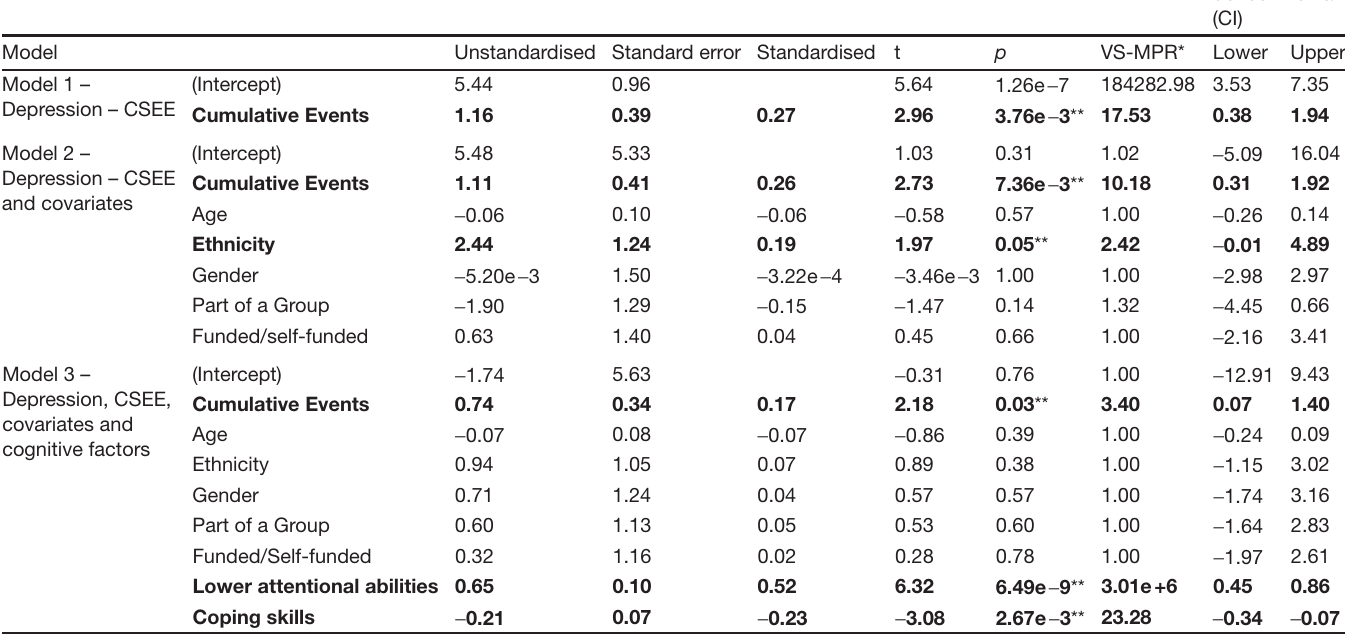
Table 4. Coefficients for depression models